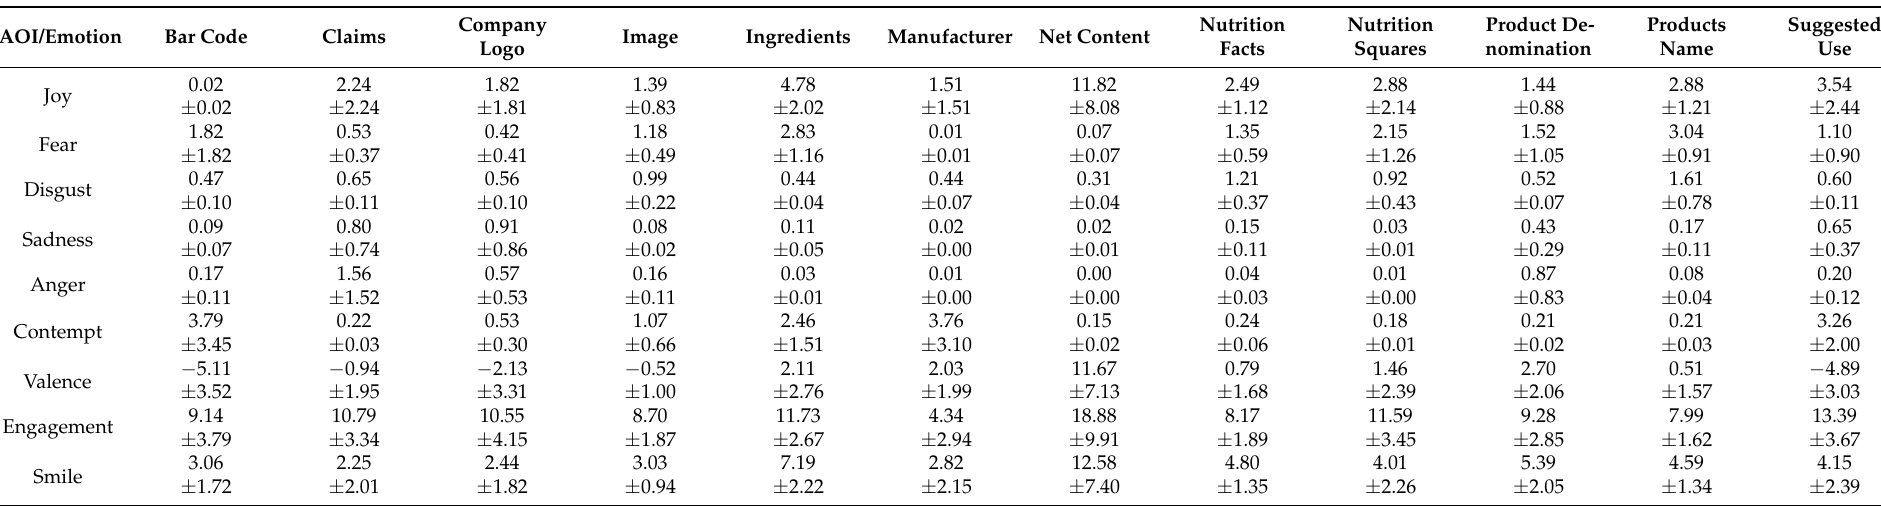
Table 1. Means (top value) and standard error (bottom value) of the emotional subconscious responses from consumers. Abbreviations: AOI: Areas of Interest. AOI/Emotion Bar